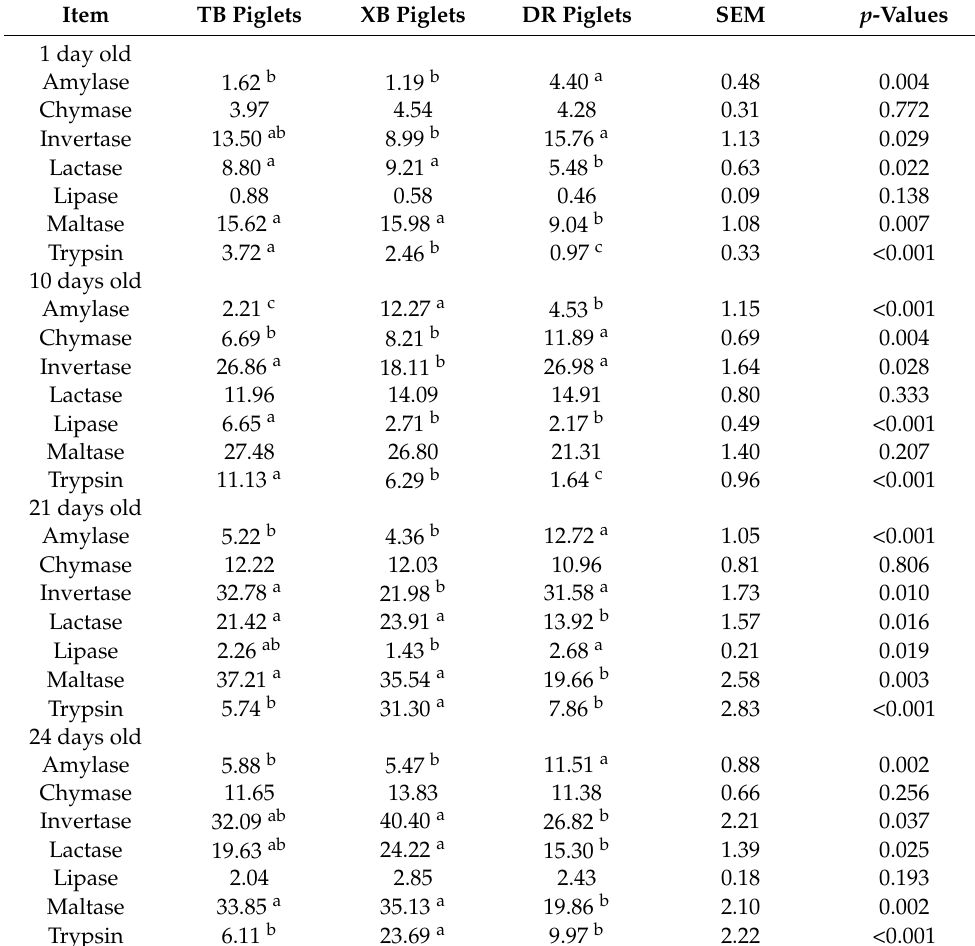
Table 6. Differences in the jejunal digestive enzyme activities of piglets at different ages (U/g). Item TB Piglets XB Piglets DR Piglets SEM p